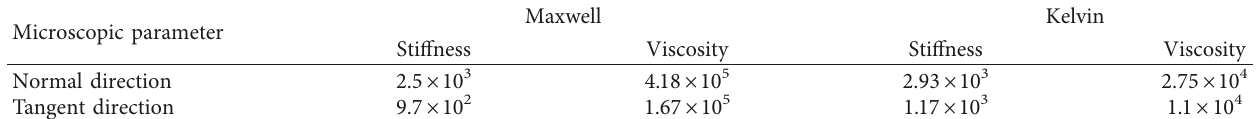
Table 9: Microscopic parameters of SMA-13 Burger’s model.